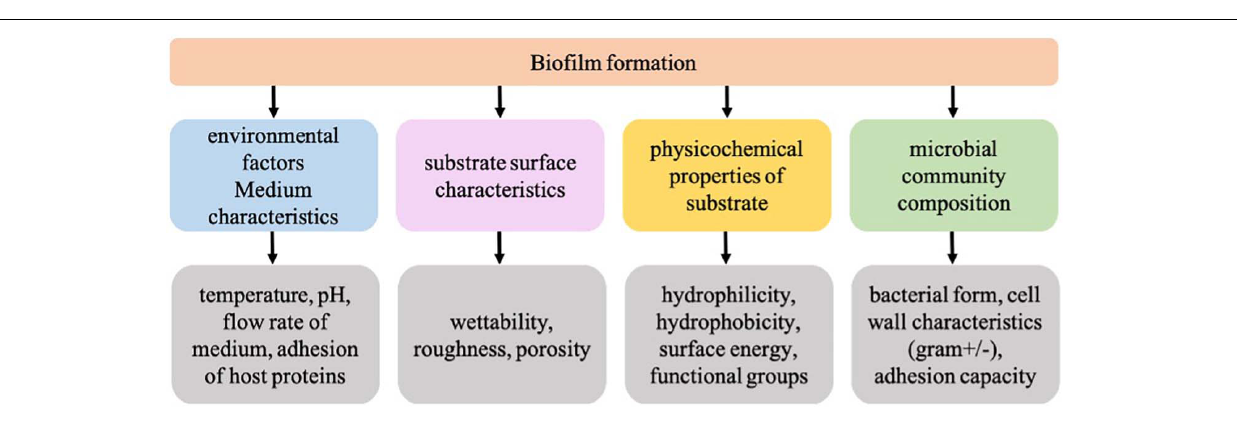
FIGURE 1 | Factors influencing the formation of biofilms on a